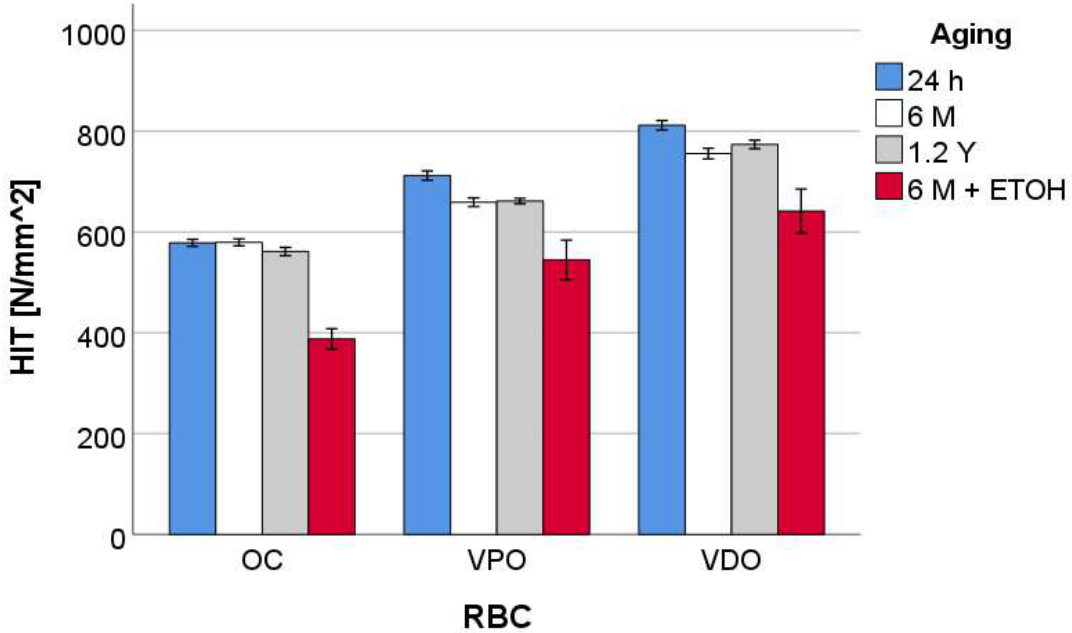
Figure 9. Indentation hardness (H IT ) as a function of frequency and aging method, exemplified for the material OC.